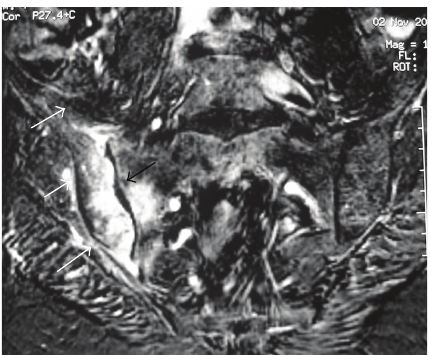
Figure 3: Post-contrast coronal T1-weighted MR image of the pelvis shows areas of diffuse enhancement of the right sacroiliac joint and the adjacent iliacus and gluteal